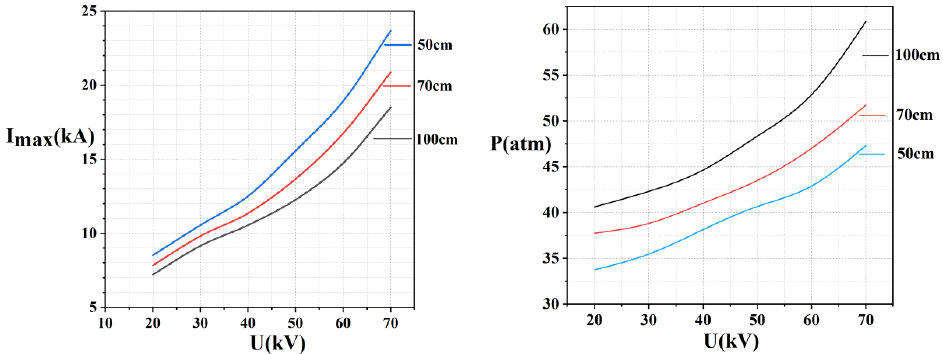
Figure 8. Simulation curves of pressure and current peaks varying with voltage (100 mm).